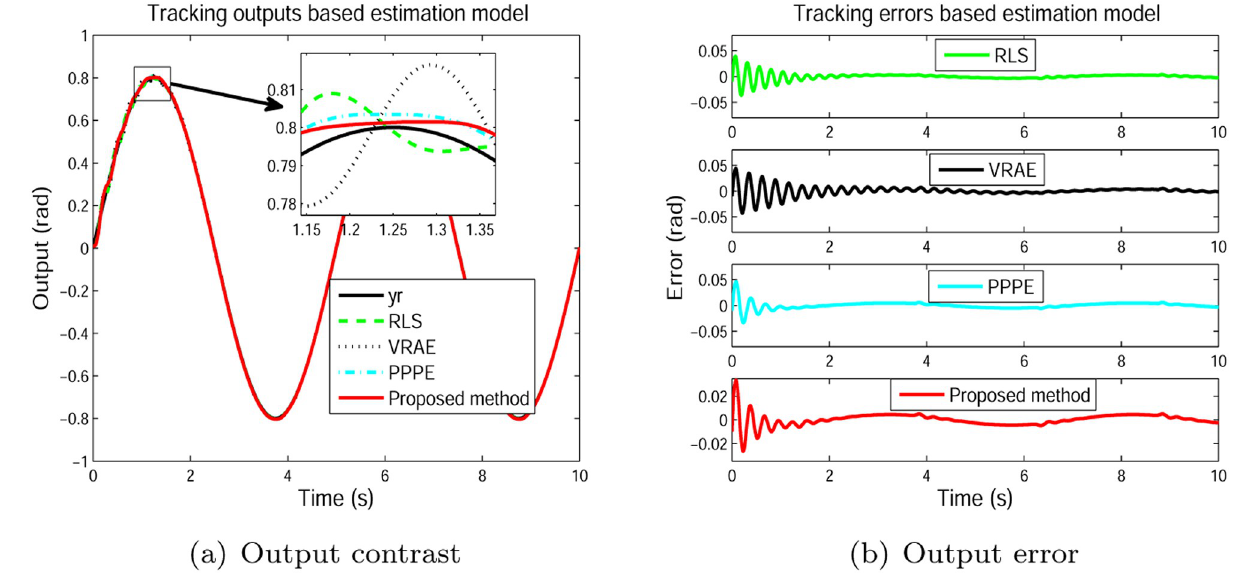
Fig 13. Model output. (a) Output contrast. (b) Output error.